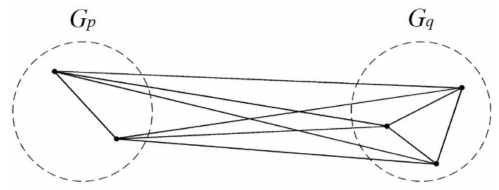
Figure 6. Conceptual diagram of the within-groups